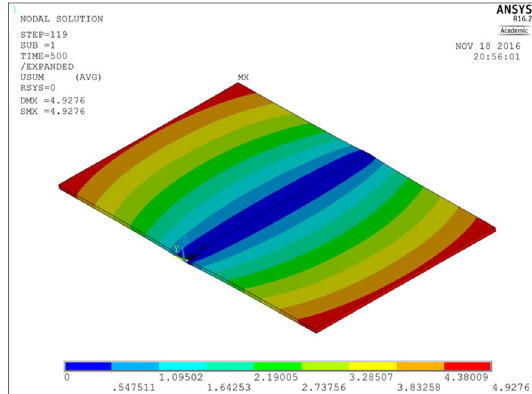
Figure 14. Angular distortion.